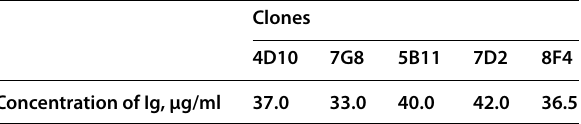
Fig. 3 Influence of lactate and ammonia concentration on each stable cell clone selection. A Level of ammonia concentration